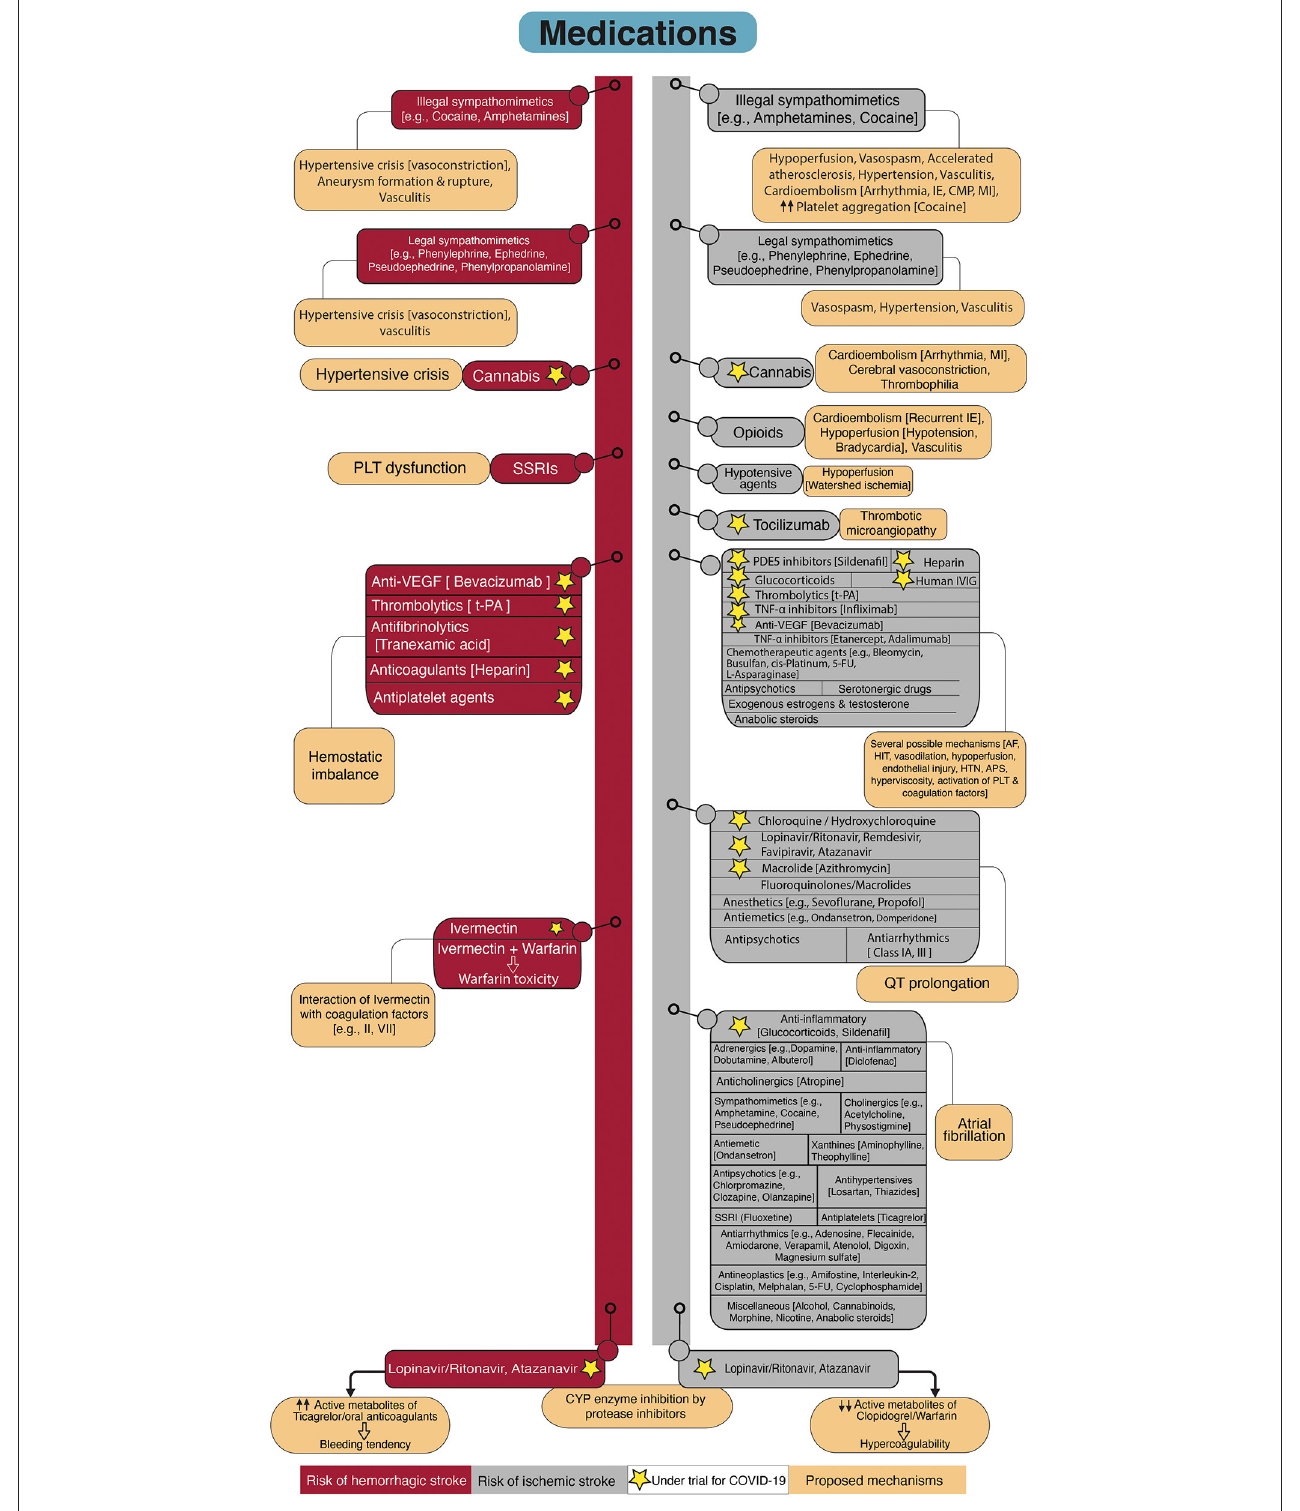
FIGURE 6 | Flowchart diagram shows drugs associated with stroke and possible underlying mechanisms. The left side of the diagram represents drugs with elevated risk for hemorrhagic stroke. The right side of the diagram shows drugs that increase the risk for ischemic stroke. Proposed mechanisms of stroke related to the drugs are provided attached to each drug. Some of the drugs are under investigation for COVID-19 which are marked by asterisks. SSRIs, Selective serotonin reuptake